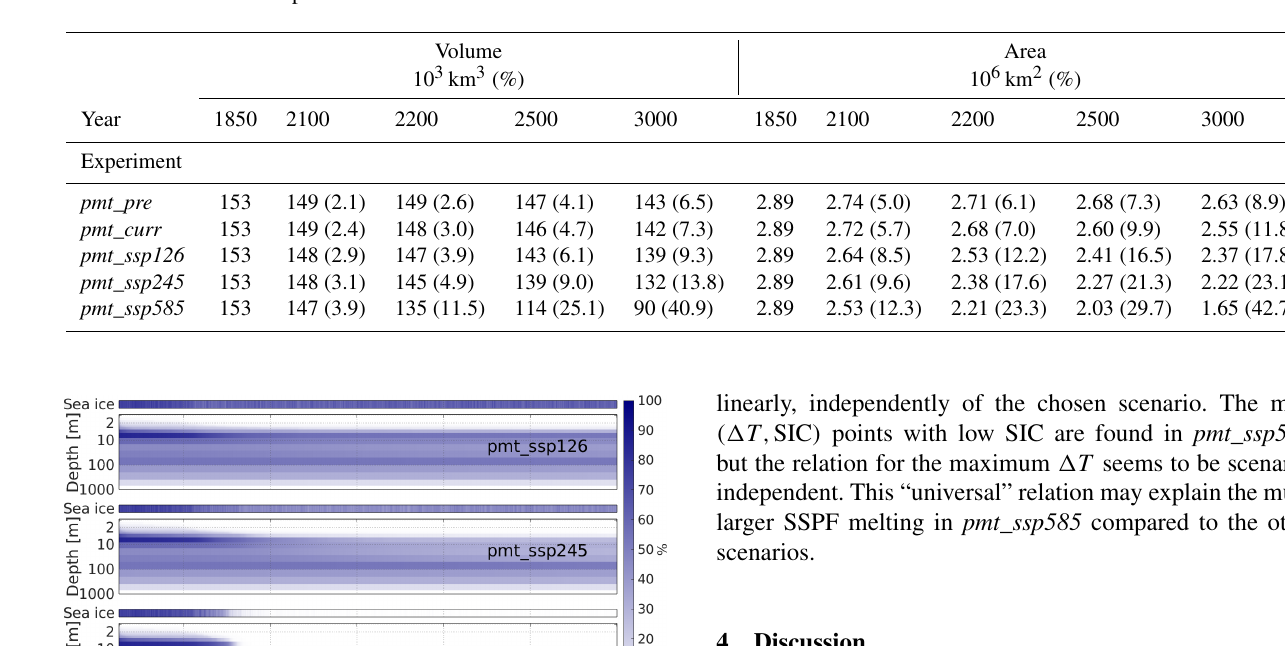
Figure 5. SSPF ice column melting for the three main experiments in the period 1850–3000. Green dots mark points entirely without SSPF ice, and blue dots mark points where all SSPF ice melted before the year 3000. Table 2. Overview over volume (left) and area (right) of SSPF ice in the main and control experiments at selected times. Numbers in brackets indicate relative loss compared to 1850.